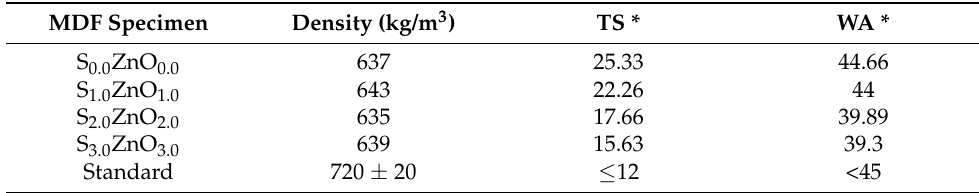
Table 6. Final physical properties of UF-ZnO-based